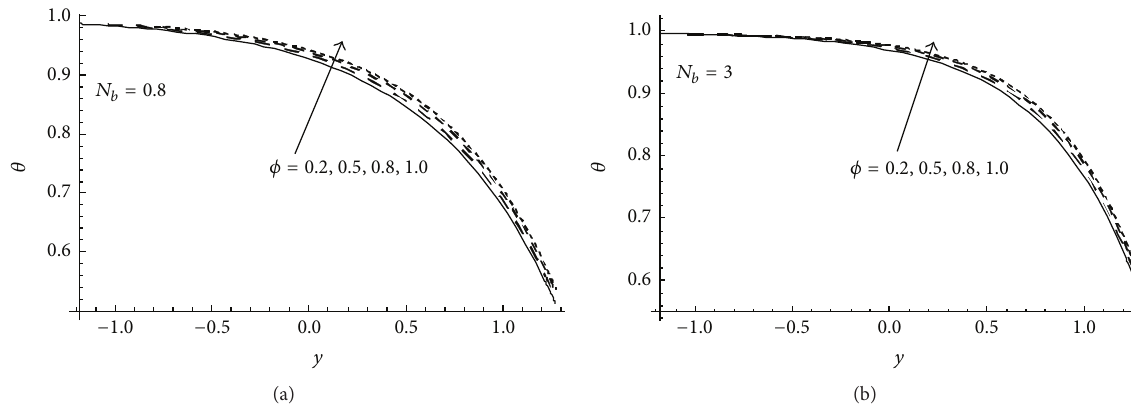
Figure 4: Variation of temperature profile at different values of 𝜙 when 𝑁 𝑡 = 5 , 𝑑 = 1 , 𝑎 = 0.5 , 𝑥 = 1 , 𝑏 = 0.5 , 𝛾 = 0.7 , and 𝛾 1 = 0.7 for (a) = 0.8 and (b) 𝑁 = 3 𝑁 𝑏 𝑏